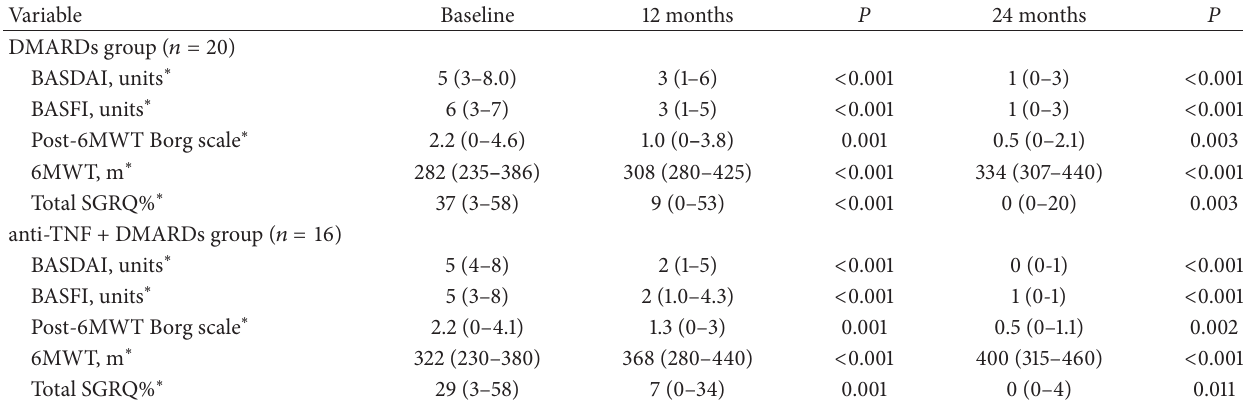
Table 2: Secondary outcomes. Intragroup changes of selected clinical variables.